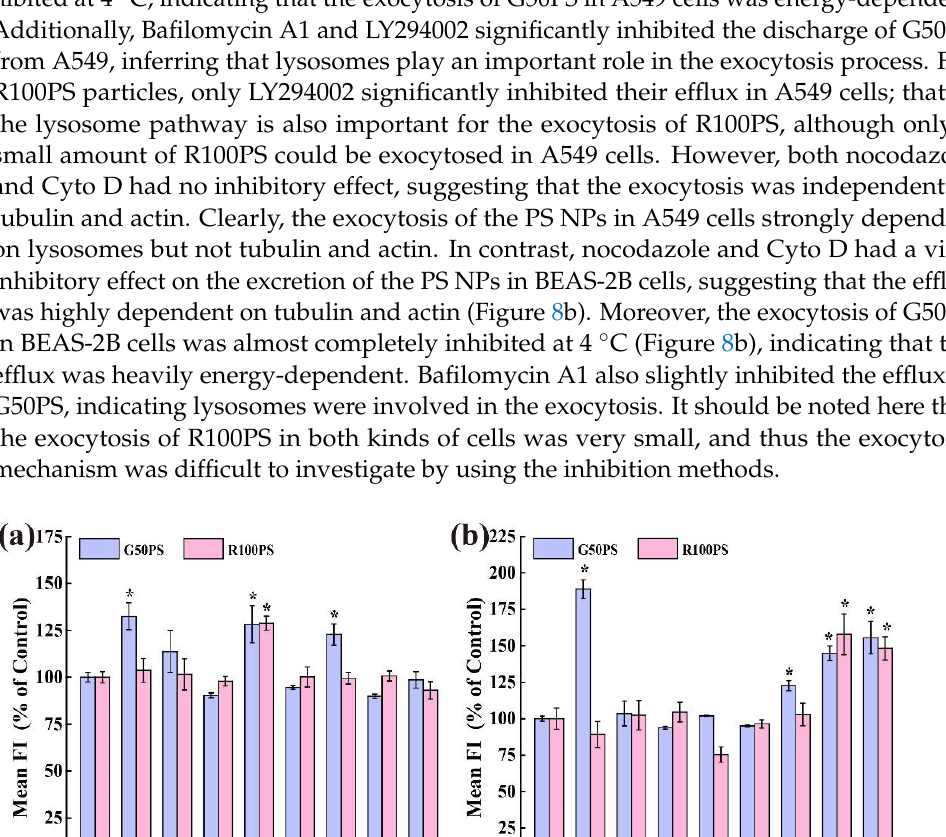
its contents in both lysosomes and mitochondria decreased, suggesting their translocation in cells and possible weak exocytosis (Figure